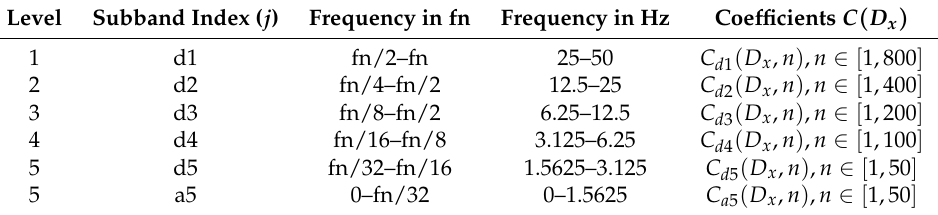
Table 2. The frequency range and coefficients of the discrete wavelet